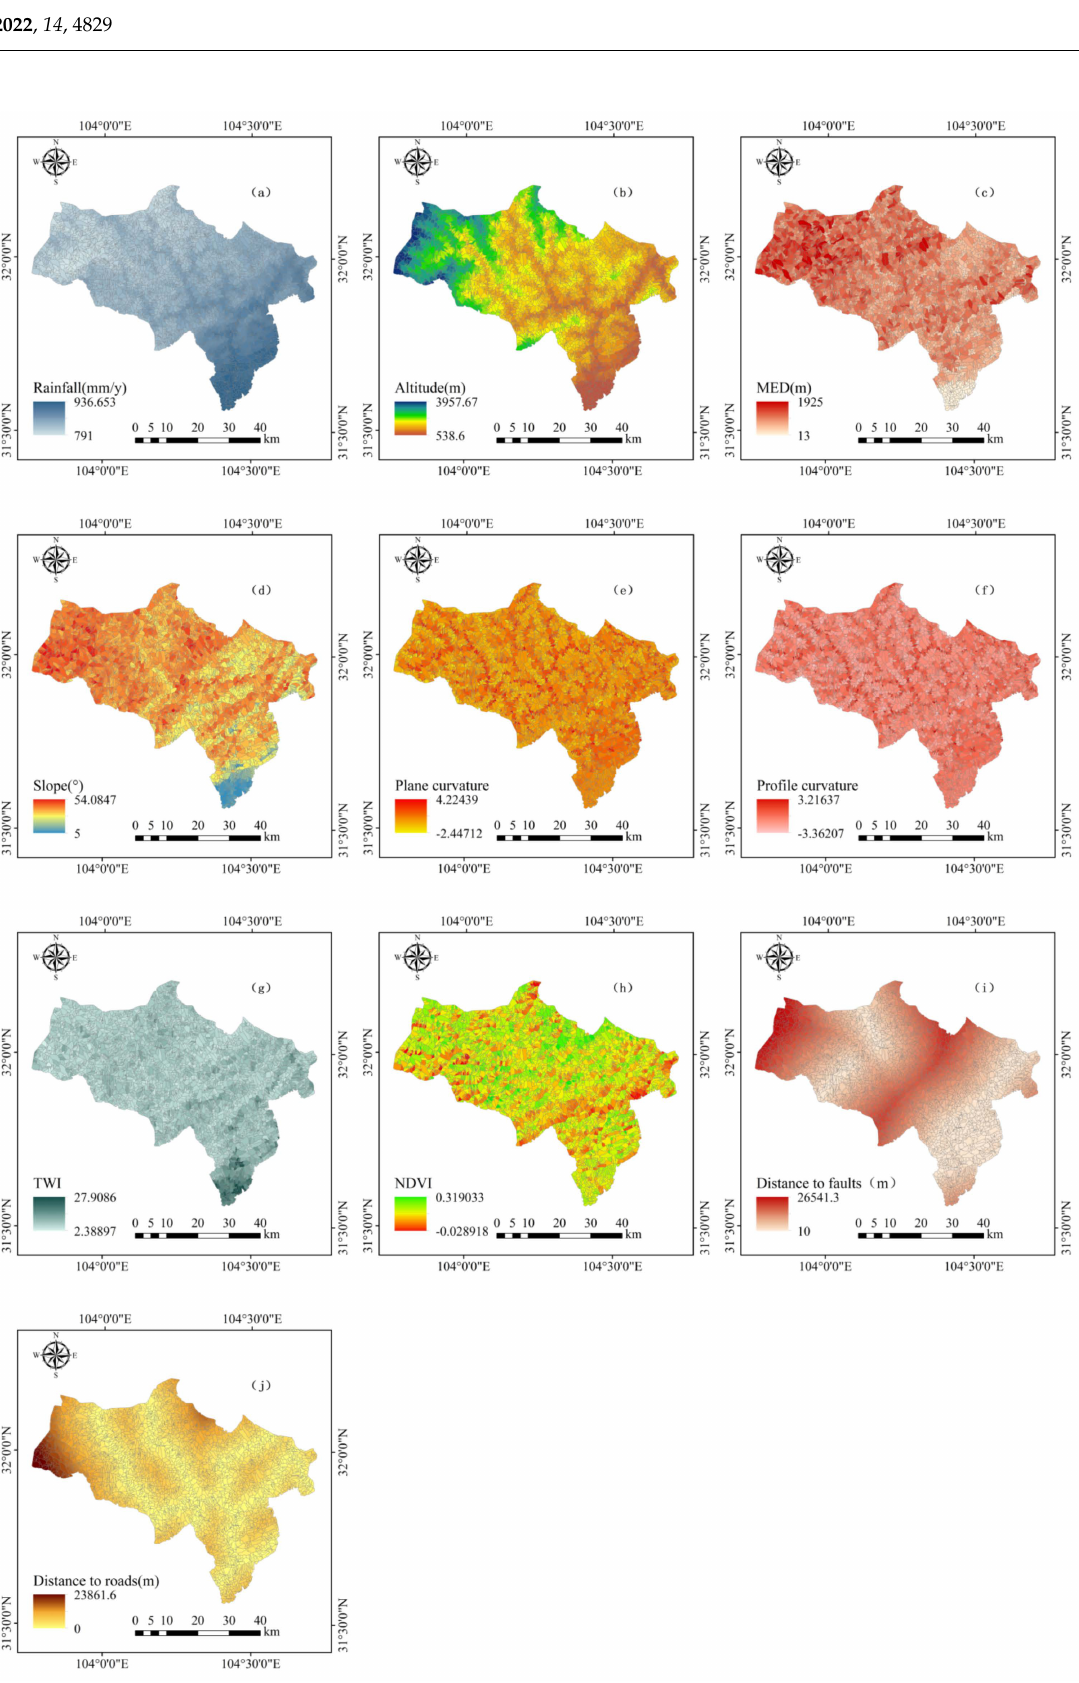
Figure 2. Conditioning factors of Beichuan County: ( a ) Rainfall; ( b ) Altitude; ( c ) MED; ( d ) Slope; ( e ) Plane curvature; ( f ) Profile curvature; ( g ) TWI; ( h ) NDVI; ( i ) DTF; ( j )